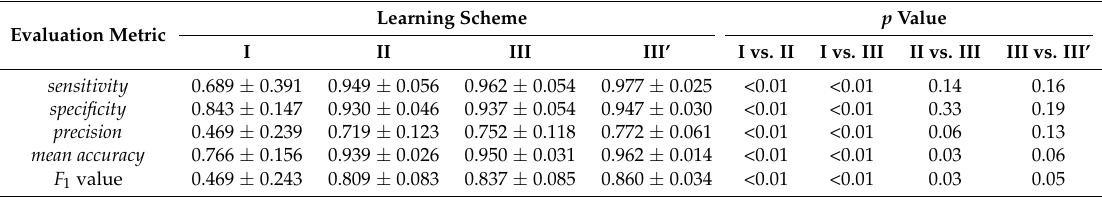
Table 1. Evaluation results of nerve segmentation with four learning